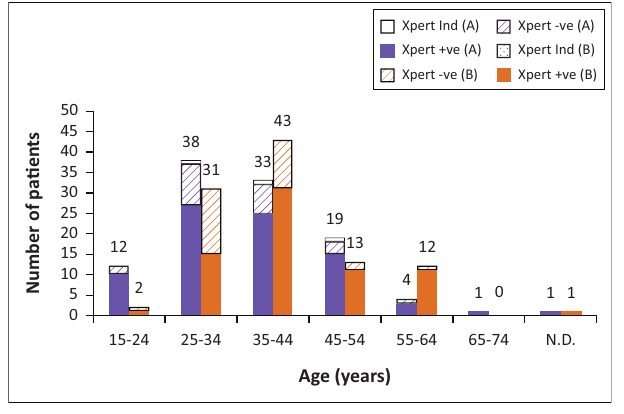
FIGURE 2: Frequency of CDI cases per ward. The number of CDI cases in 28-day windows for each ward in Hospital A (a) and Hospital B (b) over the study period. Windows move along the x -axis in one-day steps. Wards are designated as housing patients undergoing standard tuberculosis treatment (DS) or MDR/XDR treatment regimens